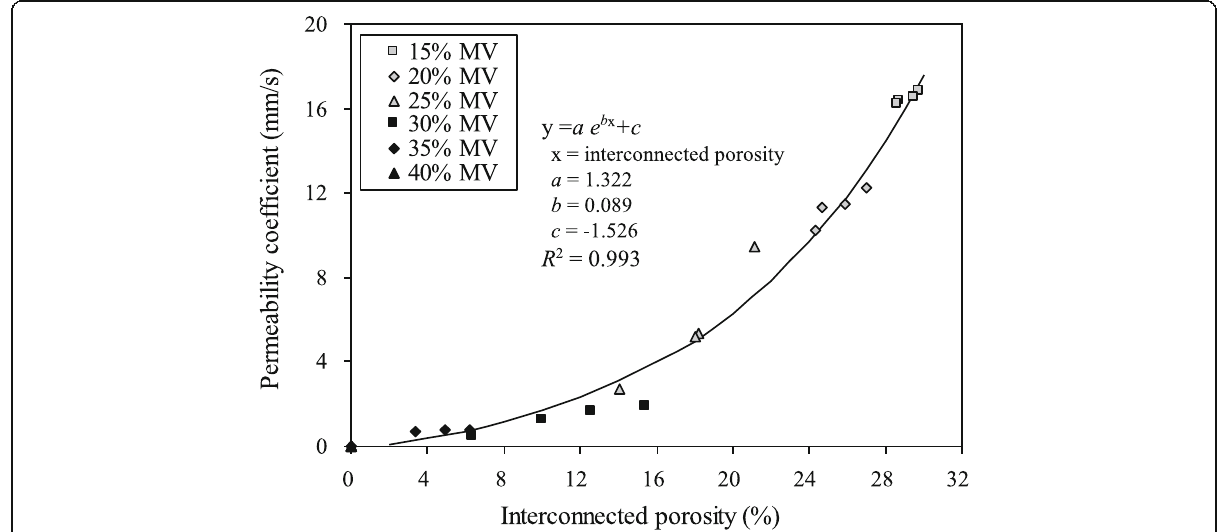
Fig. 11 Effect of interconnected porosity on submerged permeability coefficient